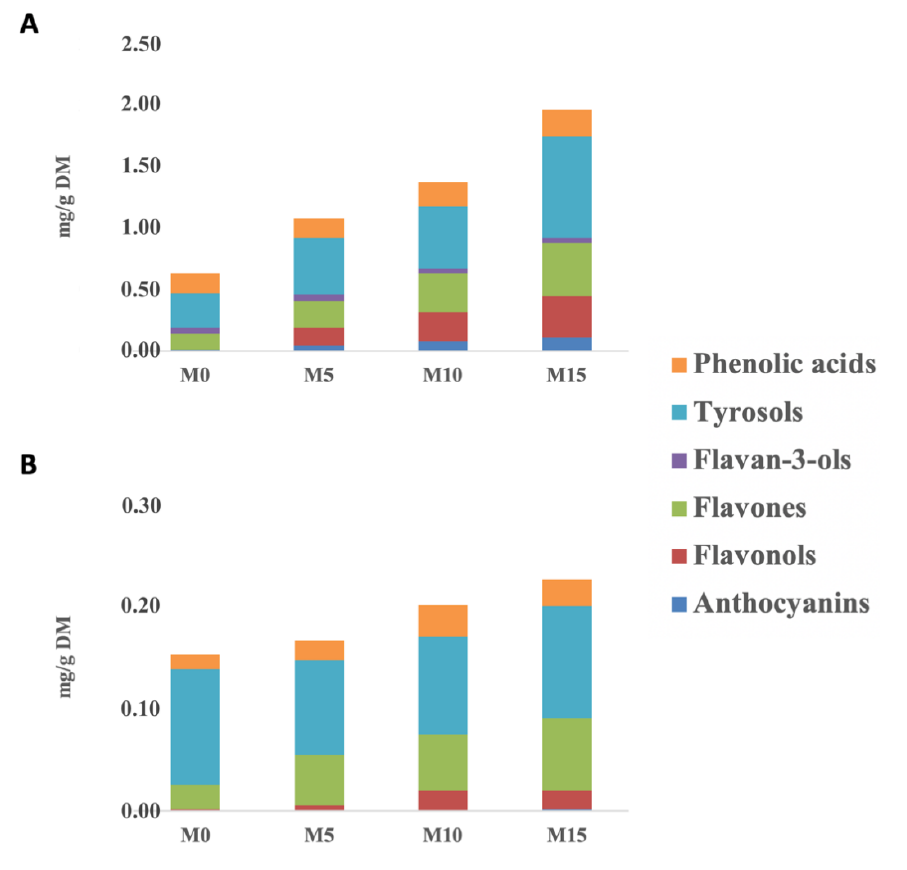
Figure 1. Cumulative phenolic composition (as mg phenolic equivalents / g dry matter) in the cooked pasta samples, considering the free ( A ) and bound ( B ) phenolic fractions. M0: 100% durum wheat semolina fresh pasta. M5, M10, and M15 = Fresh pasta produced with 5, 10, and 15 g / 100 g w / w Moringa oleifera L. leaf powder, respectively.